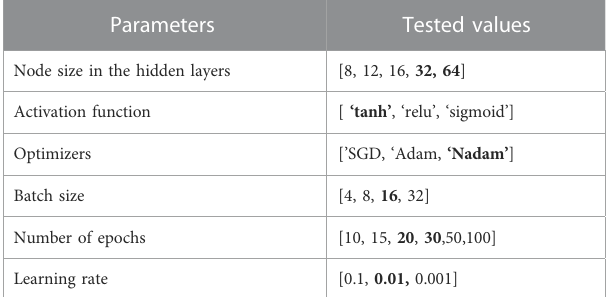
TABLE 3 The optimized parameters with multiple tested values. Bold font indicates the selected value for each parameter.